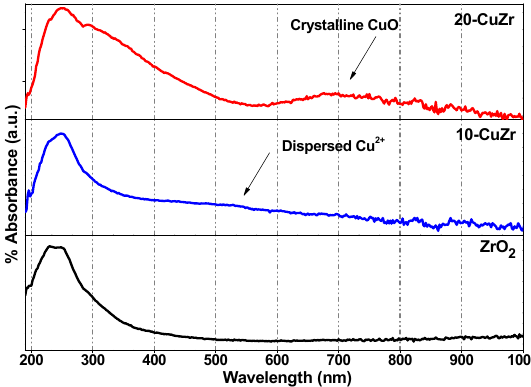
Figure 2. Diffuse reflectance UV-vis (DR UV-vis) spectra for all the samples.